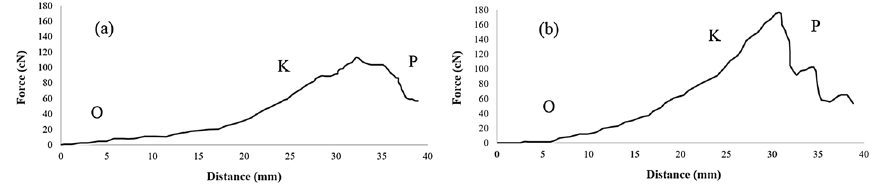
Fig. 3 Force-distance curve of pull-out test for a T1 and b T2 samples in the wale direction